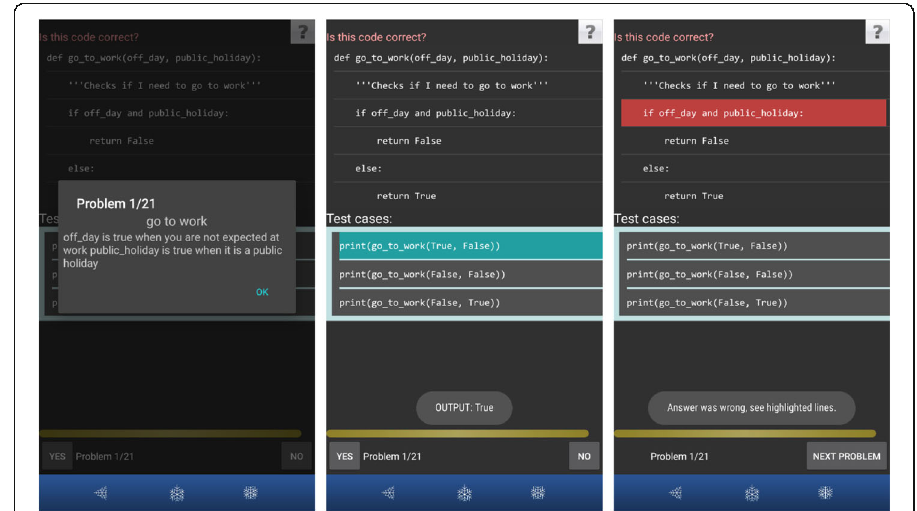
Fig. 1 Example of a Dbg_Read activity in PyKinetic_DbgOut (left: problem description; middle: code with